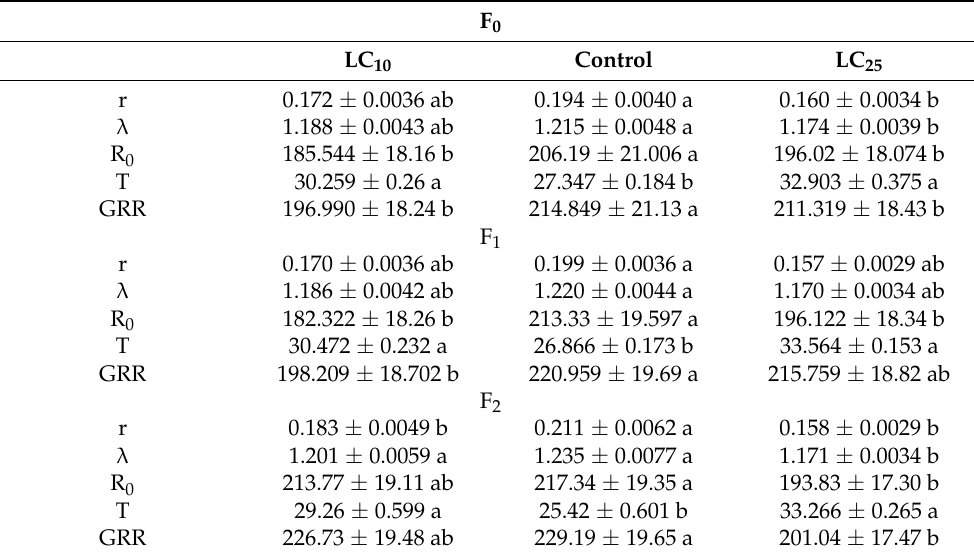
Table 4. Transgenerational effects of chlorantraniliprole on demographic traits of Spodoptera frugiperda for the F 0 , F 1 , and F 2 generations.